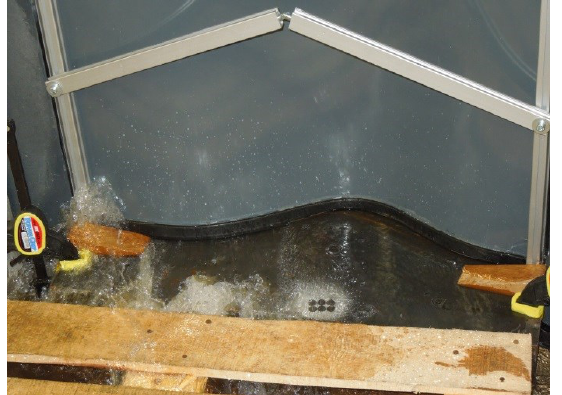
Fig. 5 . Experimental measurement: hydrodynamic load of anti- flood board